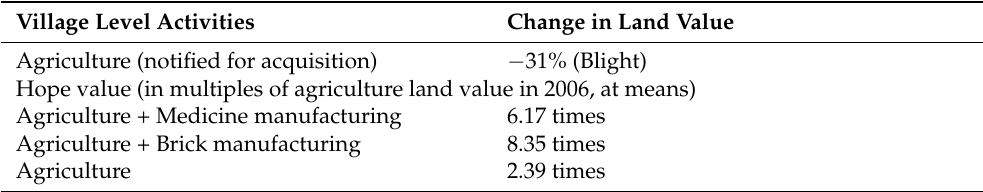
Table 5. Mean Blight (% of market value of land in non-notified villages) and Hope Value (in multiples of market value of agriculture land in non-notified agriculture dominated village in